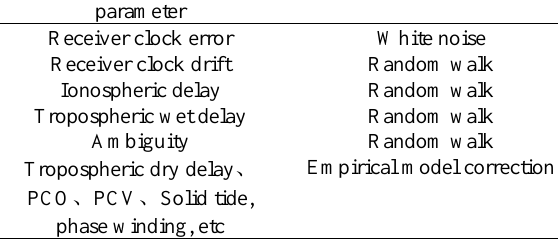
Figure 2 . Trajectory Table 2 . GNSS data processing